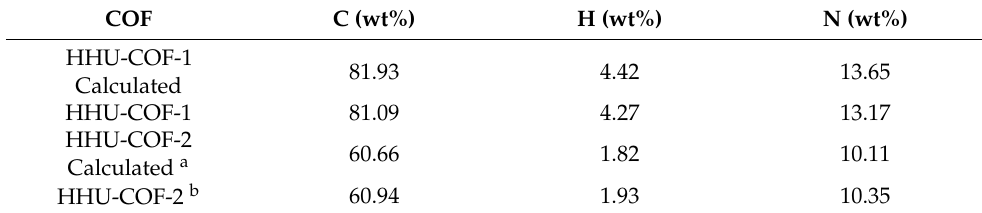
Table 1. Elemental analysis of HHU-COF-1 and HHU-COF-2. COF C (wt%) H (wt%) N (wt%) HHU-COF-1 Calculated